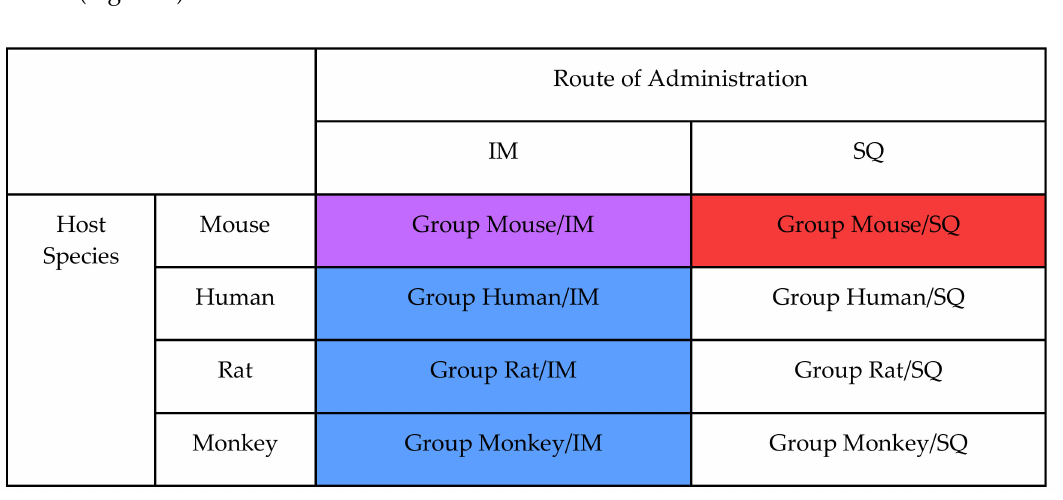
Figure 3. A representation of the definition of a comparing across group, simplified to the 2 attributes of host and route of administration (RoA). For analysis of consistency of shape across groups, a dataset from group Mouse / IM (purple cell) would be paired with only datasets from group Mouse / SQ when predicting across RoA (red cells), and with only datasets from groups Human / IM, Rat / IM and Monkey / IM when predicting across host species (blue cells). This was extended to the full 4 attribute dimensions in the